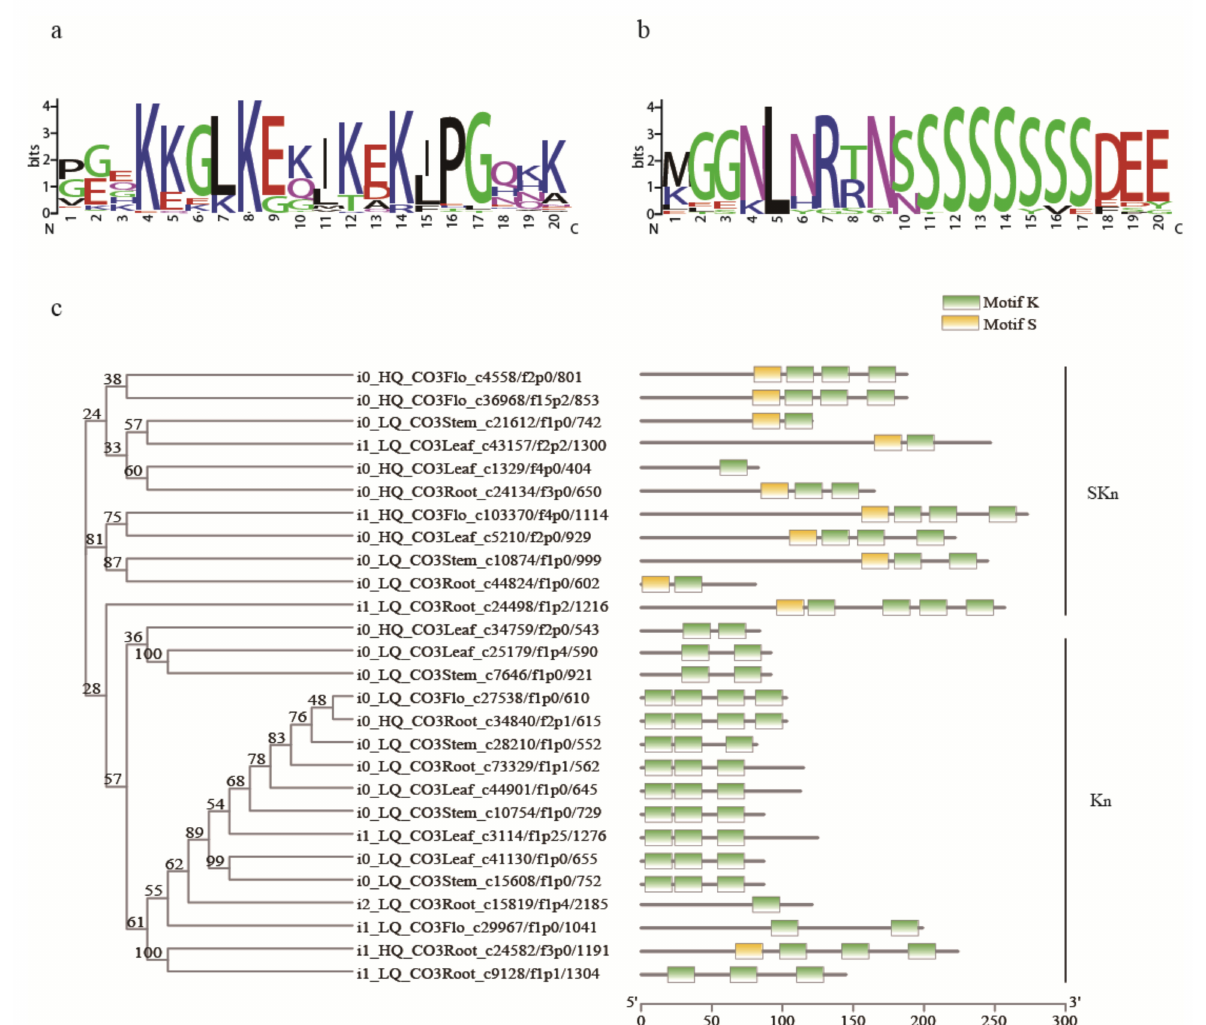
Figure 6. Conserved motif and neighbor-joining (NJ) phylogenetic tree of dehydrins. ( a ) K motif; ( b ) S motif; ( c ) NJ